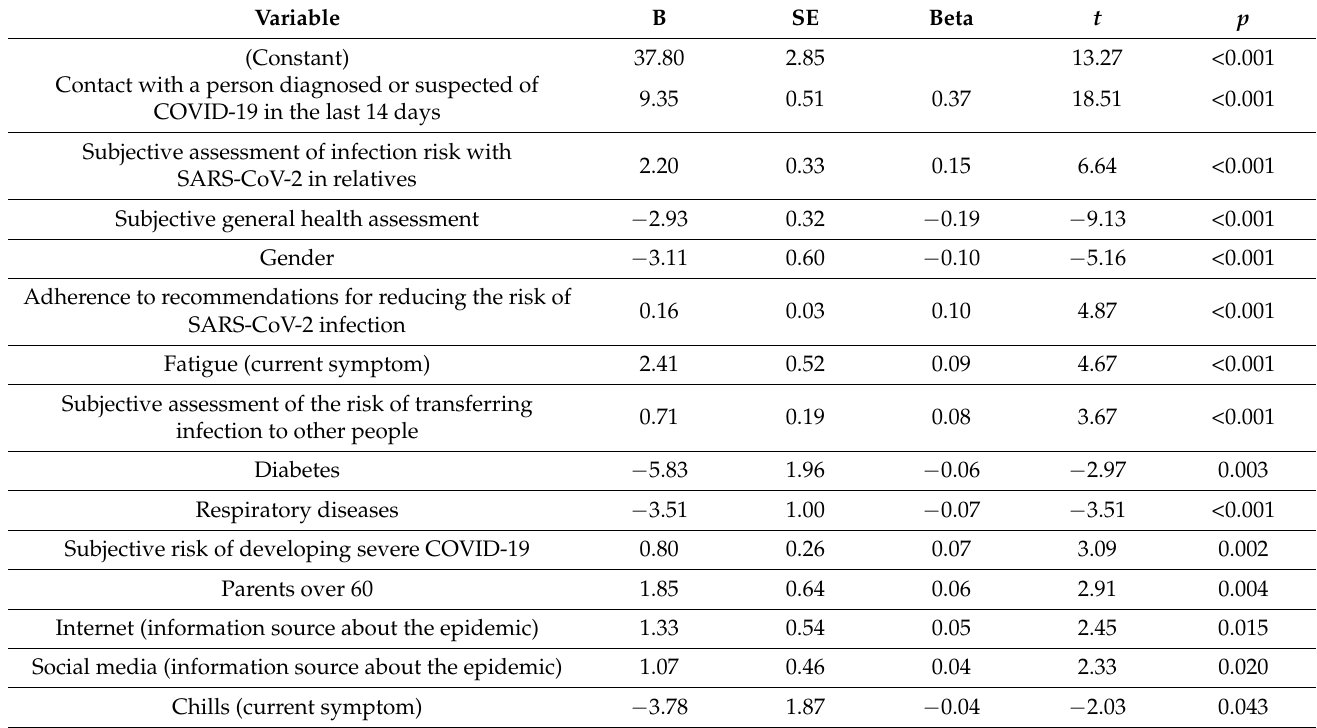
Table 5. Results of linear regression analysis for anxiety state.